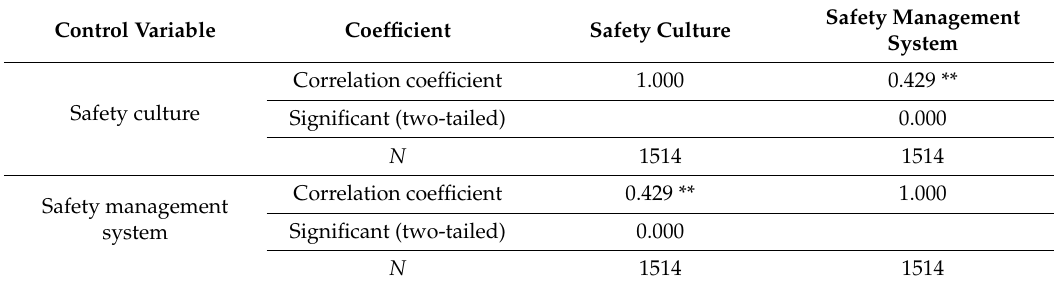
Table 3. Correlation coefficient between safety culture and safety management system.